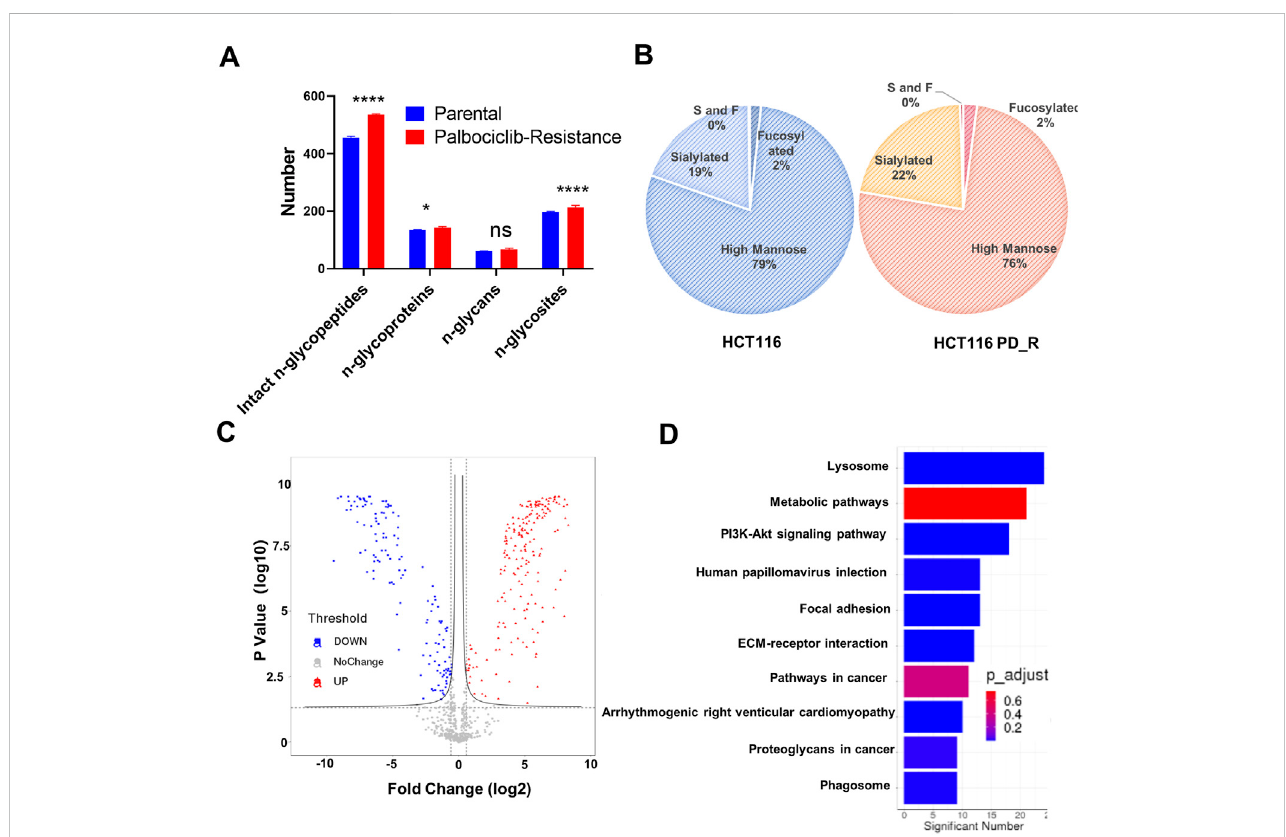
FIGURE 4 N-glycoproteomic analysis of HCT116 and HCT116 PD_R. (A) The number of identi fi ed N-glycoproteins, intact N-glycopeptides, N-glycosites, and N-glycans in two study groups. (B) The proportion of N-glycans of each type in two study groups. (C) Volcano plot of N-glycoproteomics data constructed using Fold Changes and p -value of IGPs. (D) Top ten enriched KEGG pathways of IGPs. (Statistical analysis was performed by Graphpad Prism 8.0, and the Two-Way ANOVA multiple comparisons were applied within each row. The signi fi cance of the differences was presented by starts: **** means p -value < 0.0001, *** means p -value < 0.001, ** means p -value < 0.01, * means p -value < 0.05, ns means no signi fi cant